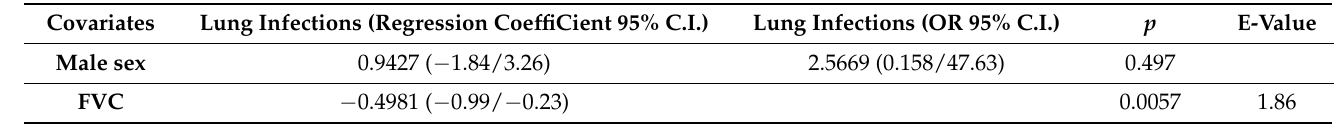
Table 4. Logistic regression multivariate